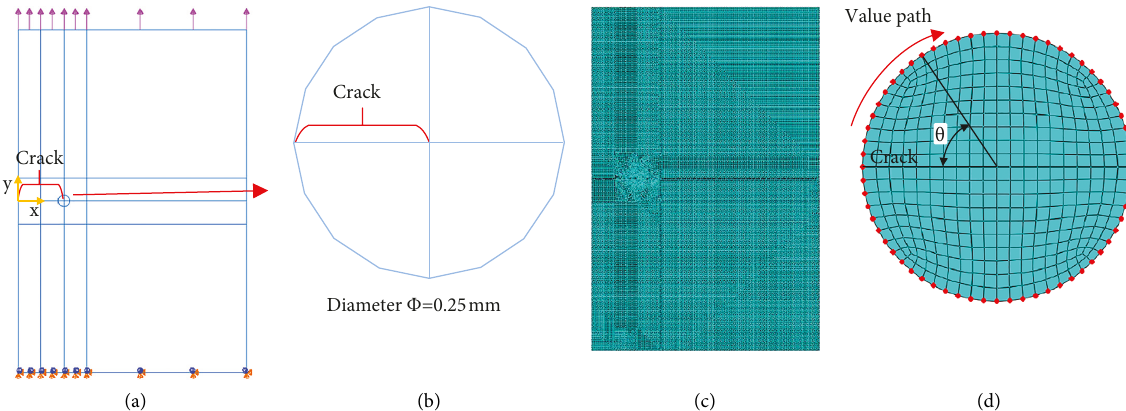
Figure 3: Finite element model of welded joint. (a) Finite element model of welded joint. (b) Geometric subdivision of crack tip. (c) Finite element mesh generation of welded joints. (d) Local meshing of crack tip.